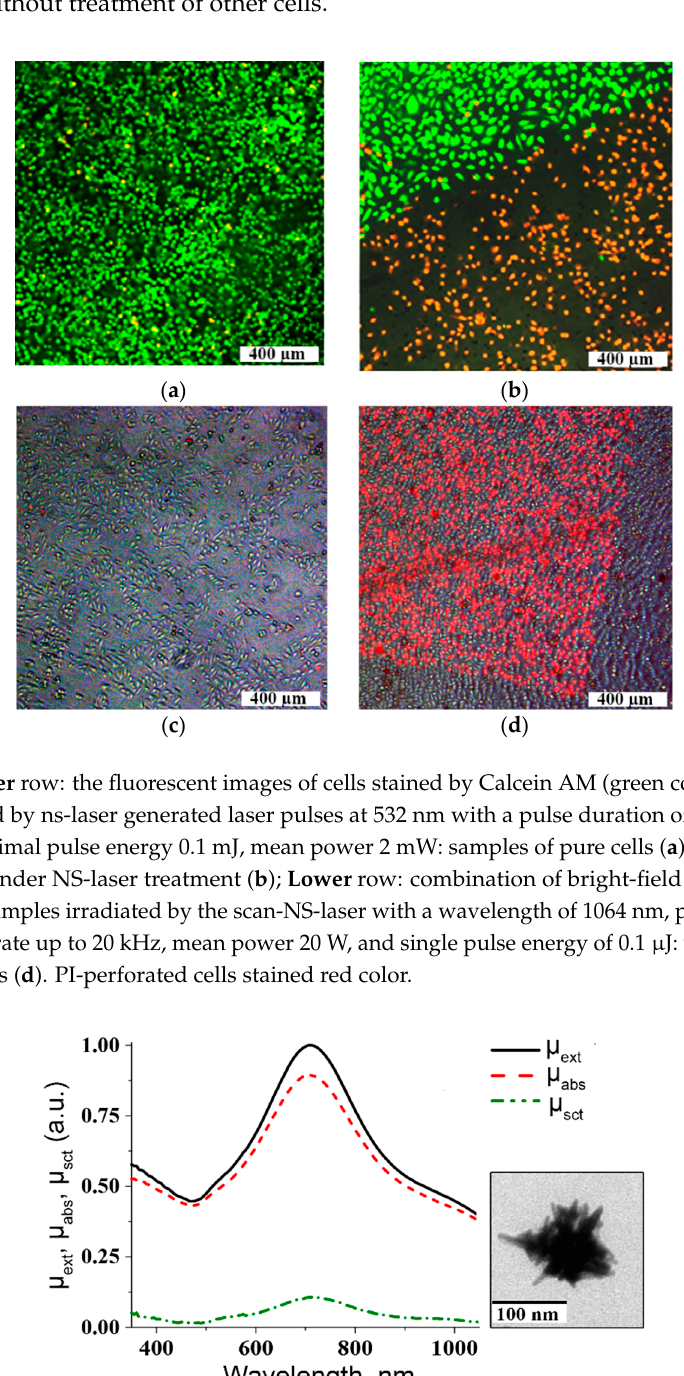
Figure 12. Typical spectra of AuNSts extinction (µ ext ), absorption (µ abs ), and scattering (µ sct ), coefficients and representative TEM image of single AuNSt ( inner part ).